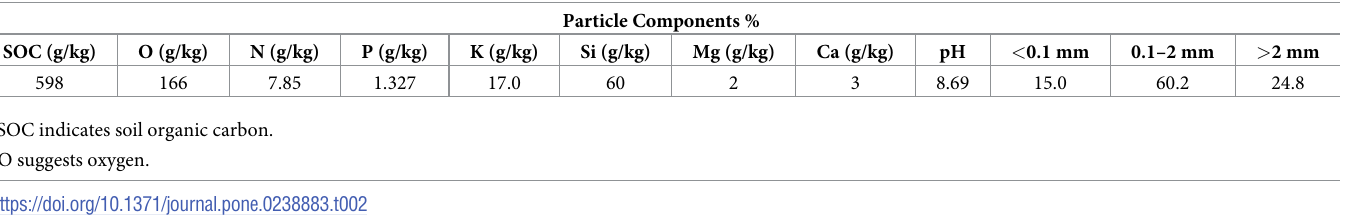
Table 2. Biochar